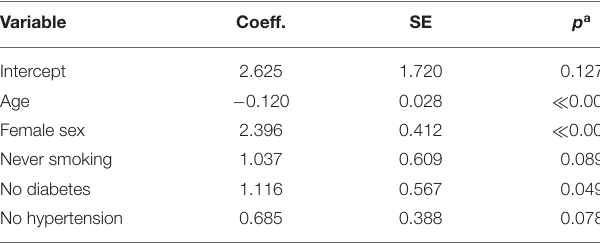
TABLE 3 | Updated minimal risk tool: estimated coefficients. Variable Coeff.